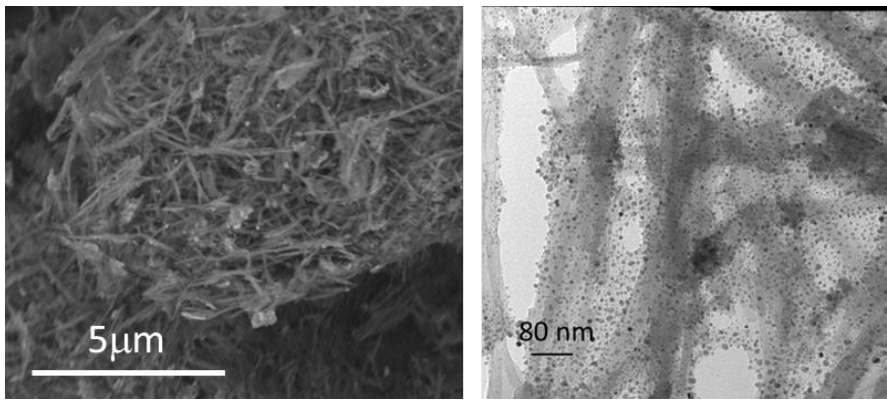
Figure 6. FE-SEM ( left ) and TEM ( right ) micrographs of additive SEPZHS.